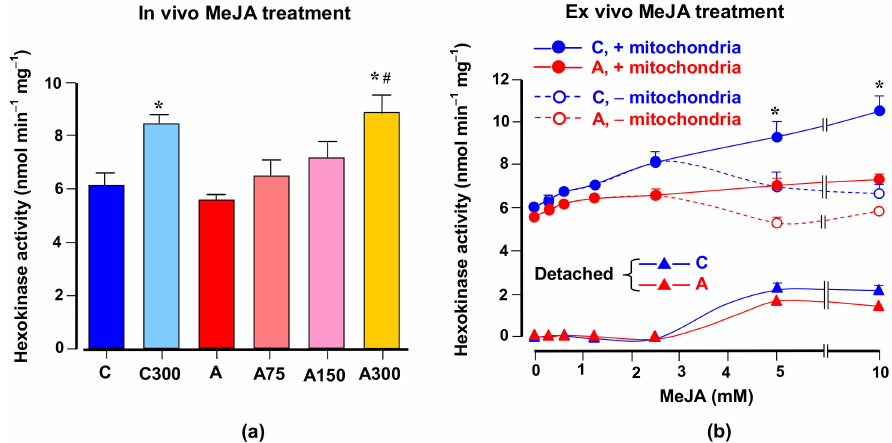
Figure 6. E ff ects of MeJA treatment on hexokinase activity. ( a ) Hexokinase activities in the cytosolic fraction of brains from healthy and arthritic rats, treated or not with di ff erent MeJA doses (C, controls; C300, controls treated with 300 mg / kg MeJA; A, arthritic rats; A75, A150 and A300, arthritic rats treated with 75, 150 and 300 mg / kg MeJA, respectively). ( b ) Hexokinase activities in the cytosolic fraction of brains from healthy and arthritic rats incubated with various MeJA concentrations with or without previous centrifugation to eliminate mitochondria and other cell components. Data are the means ± standard errors of the mean of five animals for each experimental condition. Statistical analysis: ANOVA one-way with Newman–Keuls post-hoc testing; * p < 0.05, di ff erent from the corresponding controls (C); # p < 0.05, di ff erent from non-treated arthritic rats